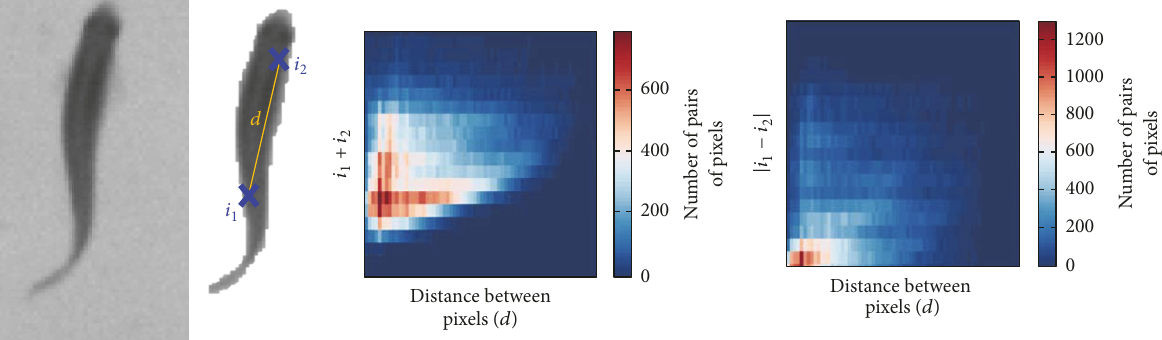
Figure 4: Calculation of “Fingerprint” features